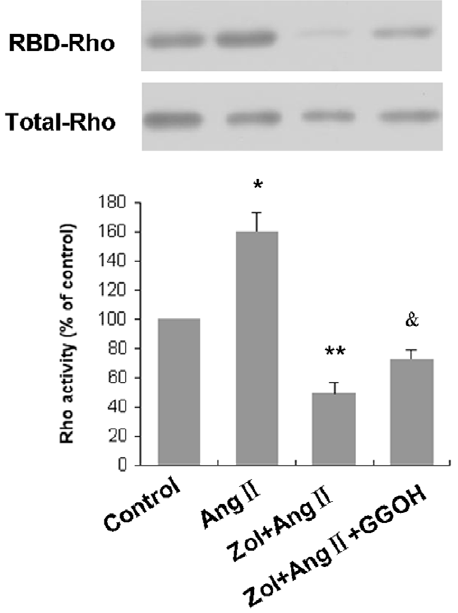
Figure 6. Effect of Zol on EPC RhoA activation. Serum-starved EPCs in the absence or presence of 50 m M Zol were combined with or without 50 m M GGOH before incubation with 1 m M Ang II for 15 min. RBD-RhoA proteins were detected by Western blot using monoclonal antibody against RhoA (upper panel). Western blotting of the total amount of RhoA in cell lysates (lower panel) was also performed in the same lysates. The results are representative of three independent experiments. * P , 0.01 vs. control group; ** P , 0.01 vs. Ang II group; &P , 0.01 vs. Zol + Ang II group.